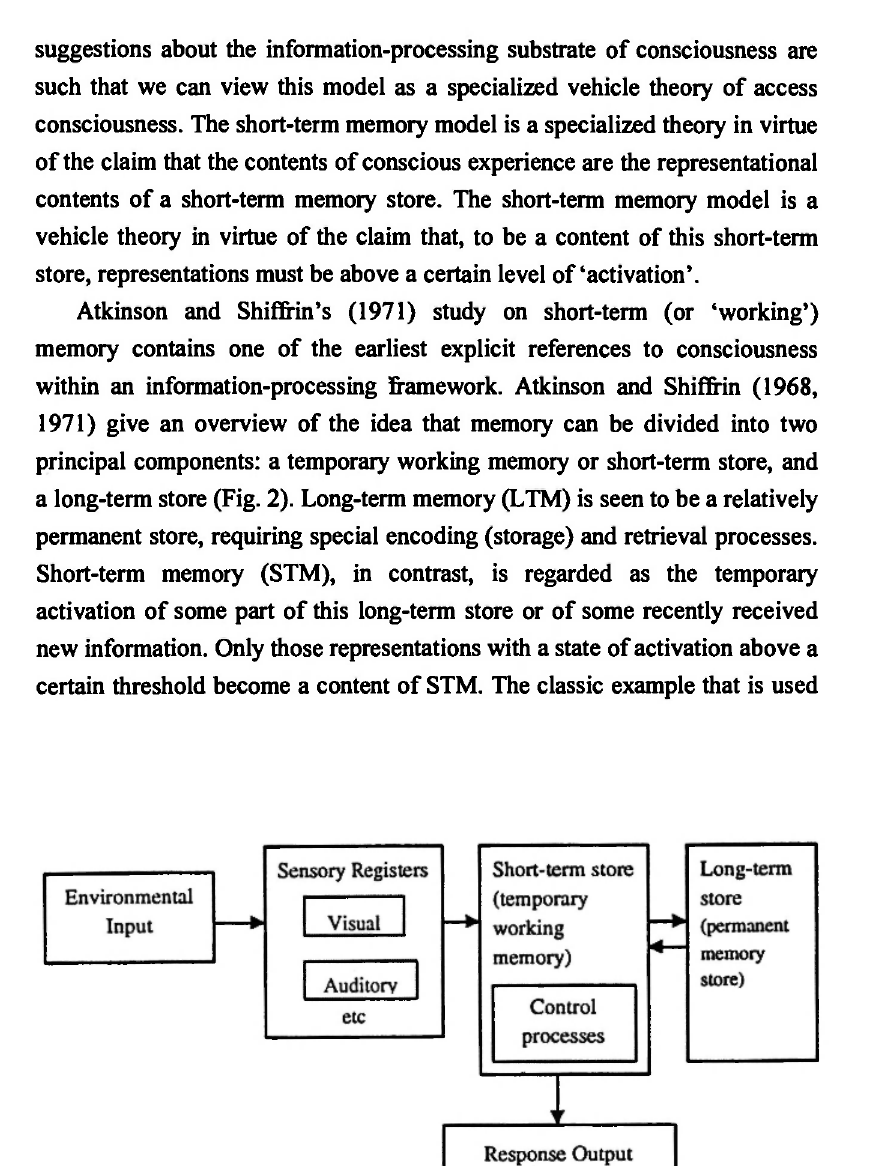
Fig. 2: Atkinson and Schiffrin's (1971) model. The short-term store is a consciousness box, namely, an informational processing mechanism whose representational contents are the contents of conscious